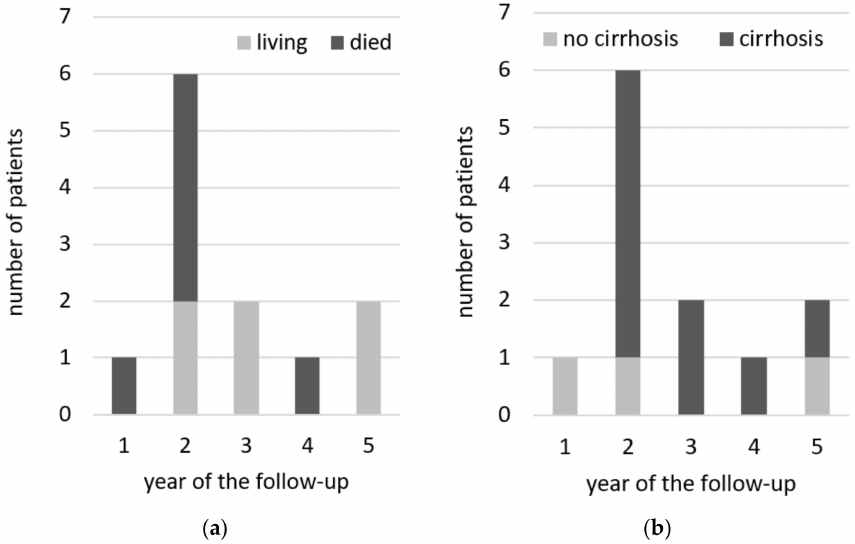
Figure 2. Hepatocellular carcinoma diagnosed in particular years of the follow-up, with regards to patients survival ( a ) and presence of cirrhosis at the baseline ( b